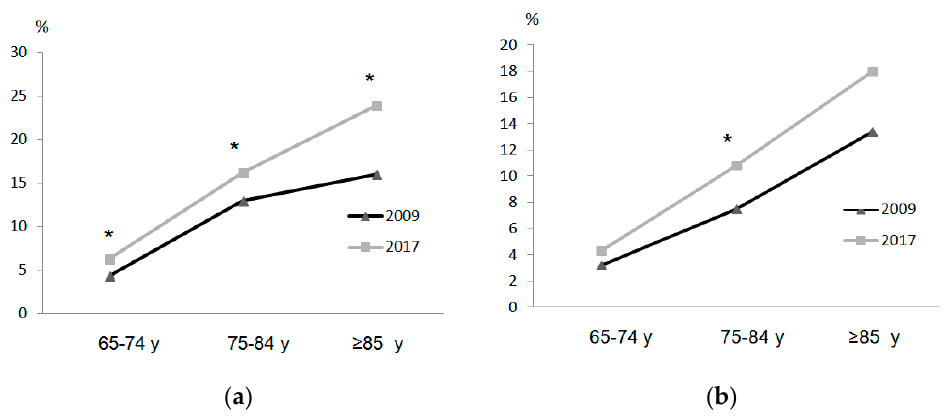
Figure 2. Difficulty walking 500 m without assistance: women ( a ) and men ( b ). * p < 0.05.